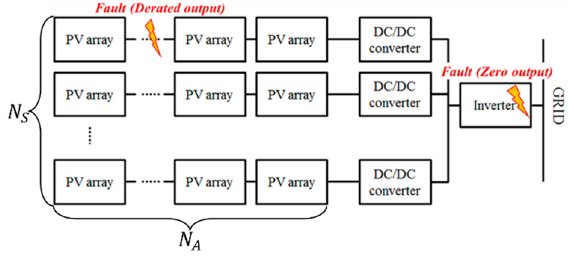
Figure 2. Individual and Whole Capacity Model of conventional generators (CGs).